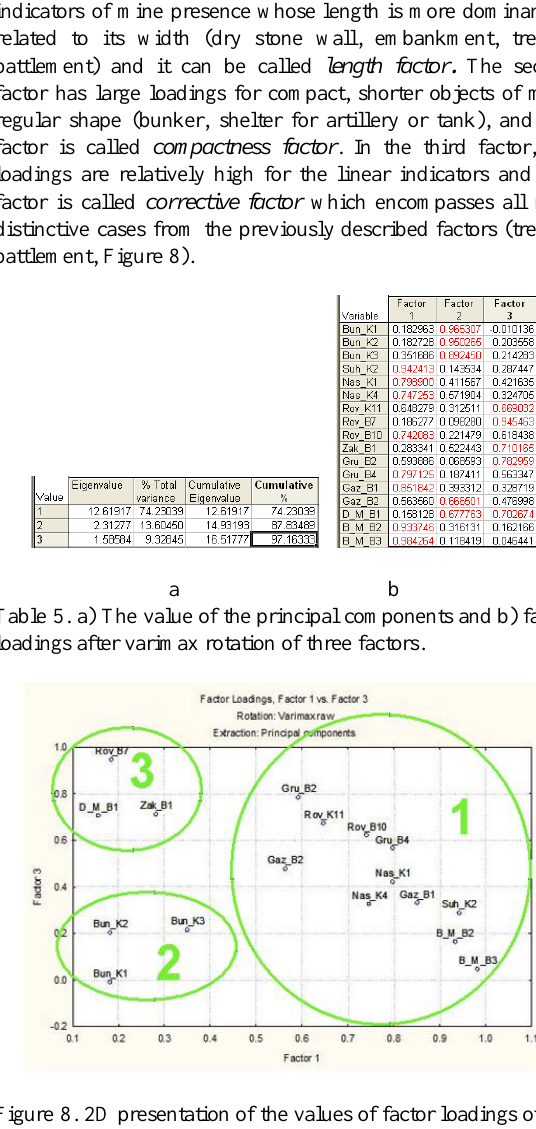
Figure 8. 2D presentation of the values of factor loadings of the first (X axis) and the third factor (Y axis) from the Table